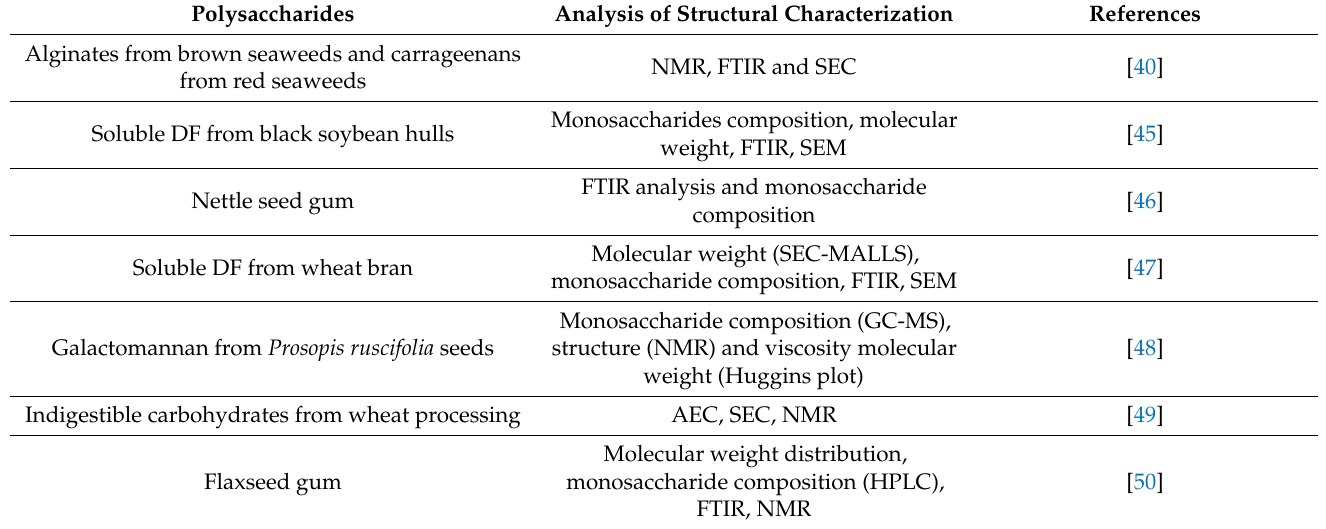
Table 1. Analytical techniques for structural characterization of dietary fiber